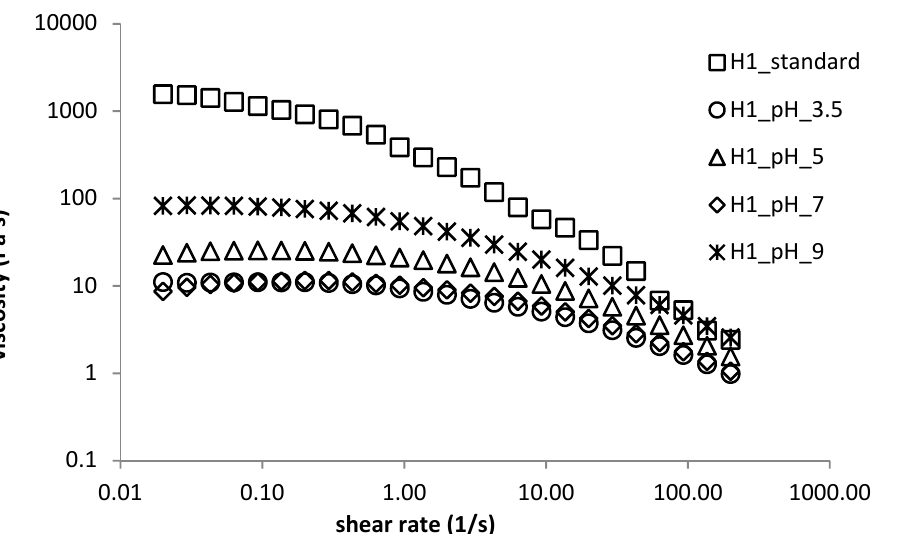
Figure 6. Flow properties of H1 sample—pH dependence.